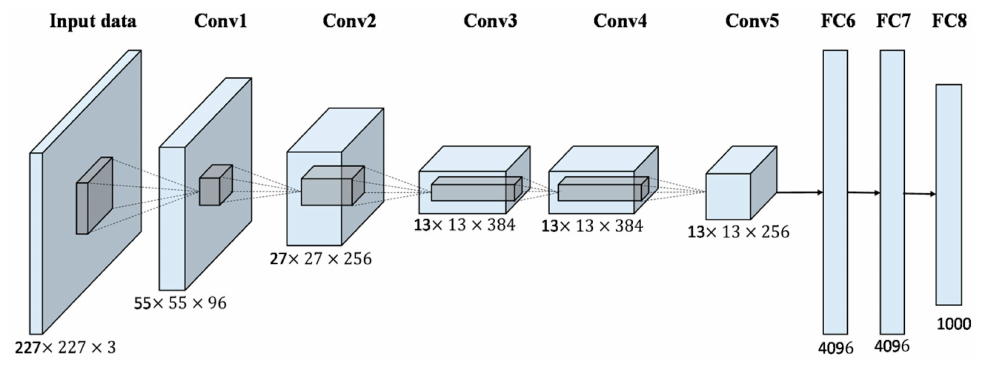
Figure 4. Architecture of the AlexNet model. Table 2. AlexNet